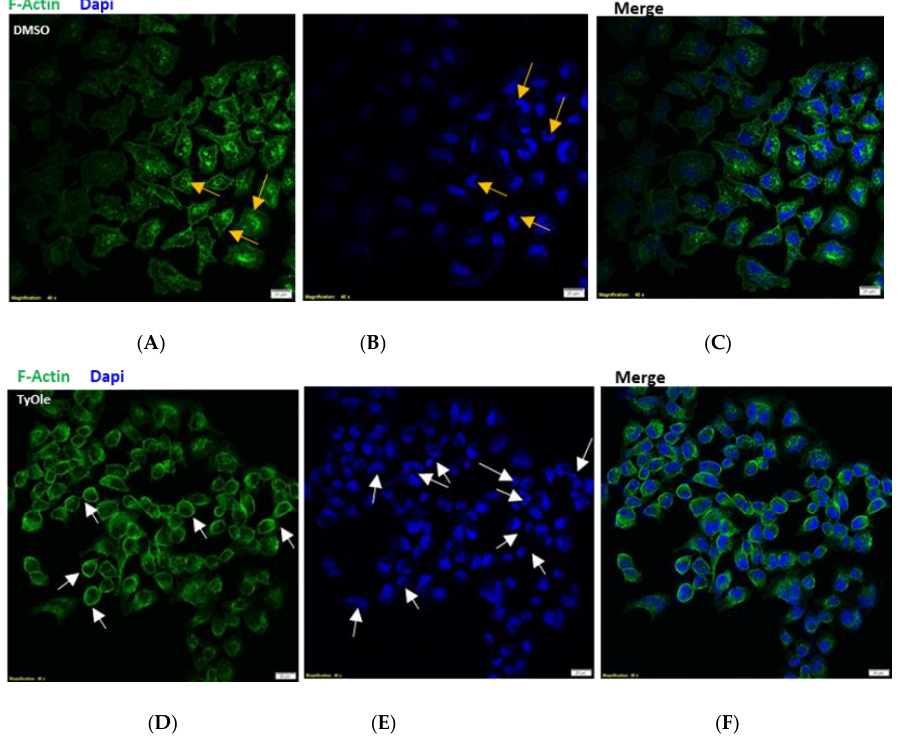
lected for further experiments. As it is shown in Figure 4, cytoskeletal remodeling was